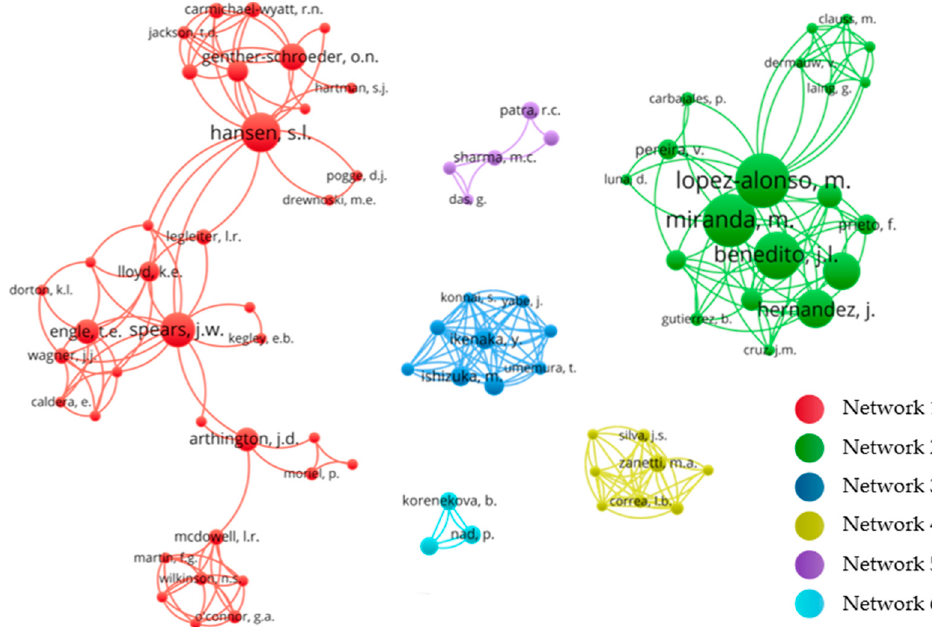
Figure 2. Co-authorship networks active in the period 2000–2022 in research on trace elements in beef cattle production. The nodes represent the relevance of the authors; the links represent the co-authorship among authors, and the colors represent the main networks identified.